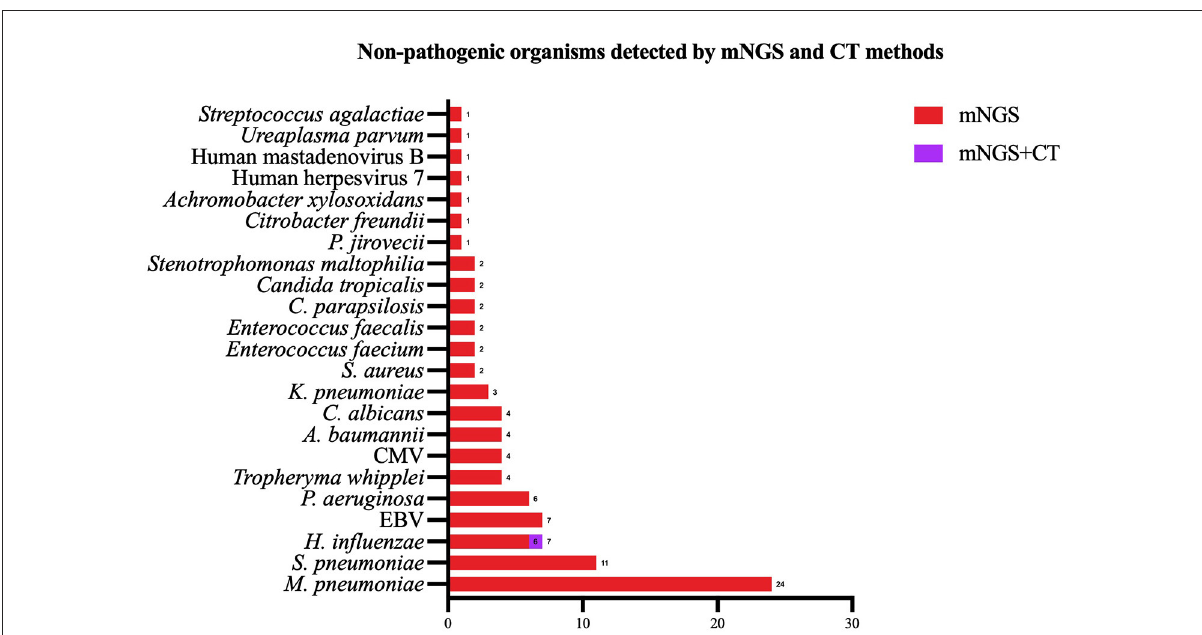
FIGURE5 Non-pathogenic pathogens identified using both the metagenomic next generation sequencing (mNGS) and conventional tests (CT) methods, mNGS only. mNGS, metagenomic next generation sequencing; CT, conventional test, HBoV, Human bocavirus; CMV, Cytomegalovirus; EBV, Epstein–Barr